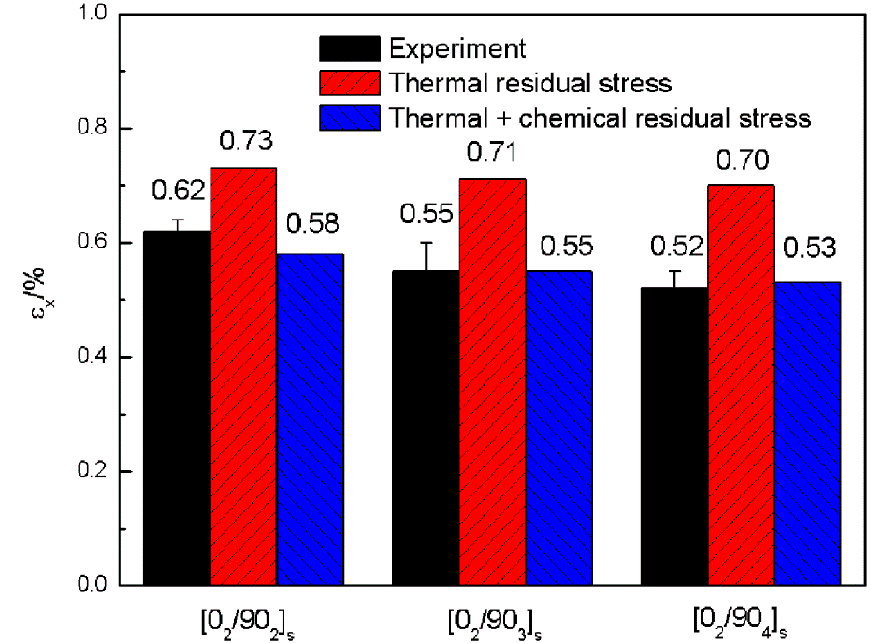
Figure 10. The relationship between the onset of the crack and the applied mechanical strain along x direction.